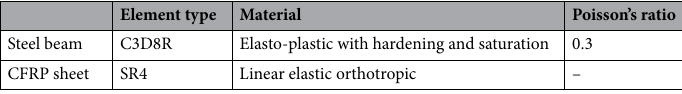
Table 2. Material properties.